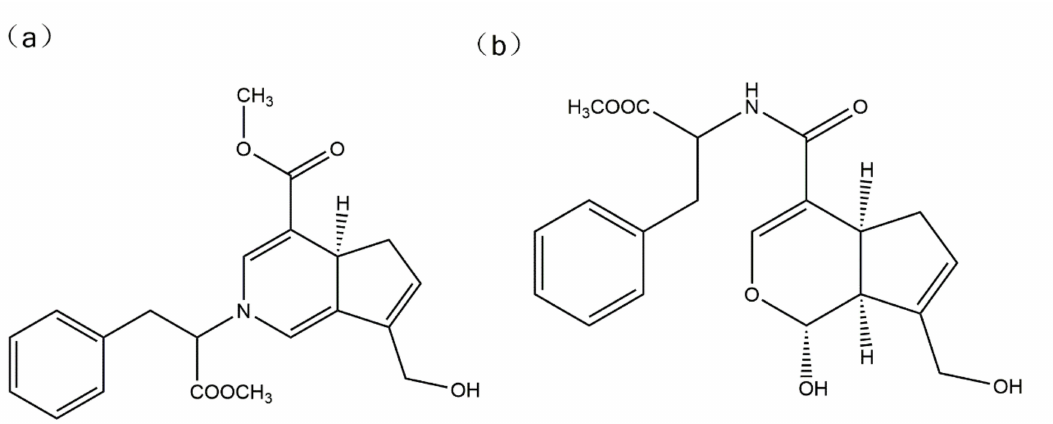
Figure 1. Simulation of the chemical structural formula of the intermediate product 1 ( a ) and intermediate product 2 ( b ) of the water-insoluble gardenia blue pigment.